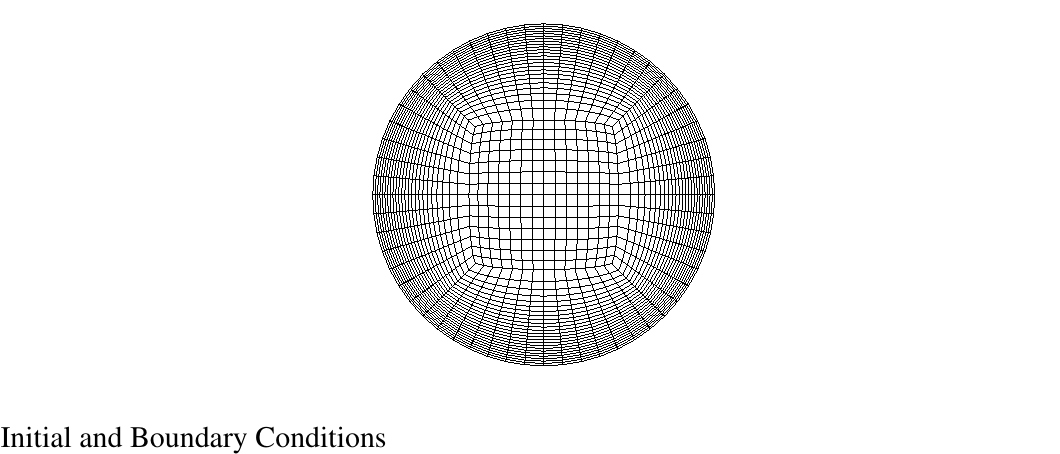
Figure 4. Mesh in the calculation